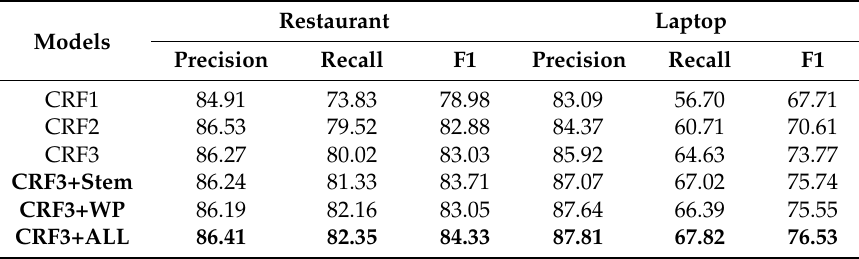
Table 4. Results of the Aspect Term